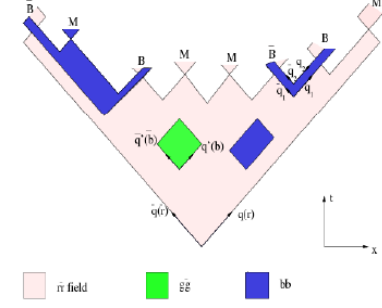
Figure 4. The mesons (M) and baryons (B) production in the string fragmentation